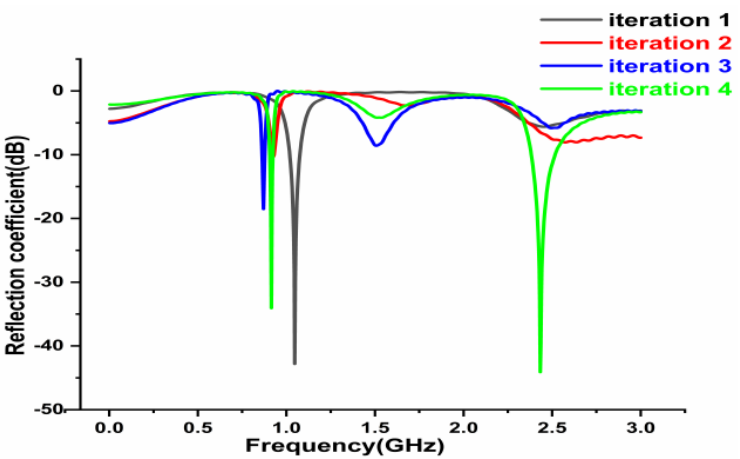
Figure 3. Results of antenna iterations.